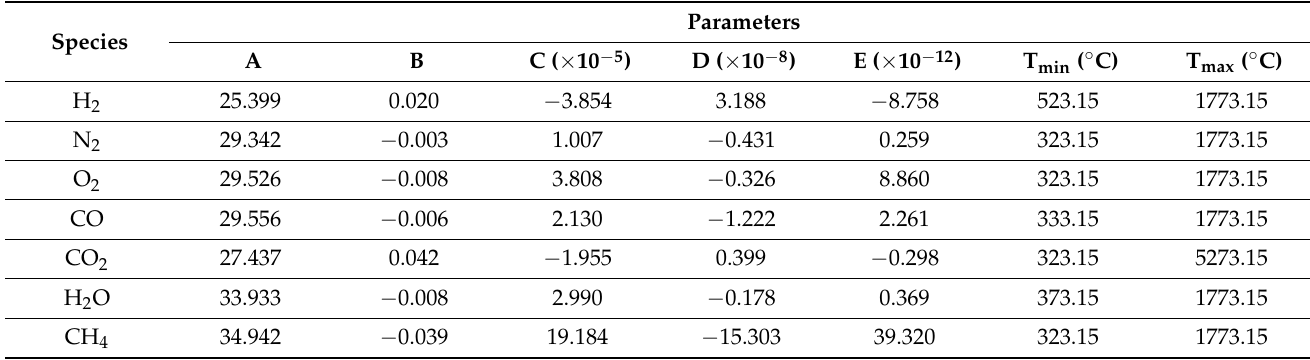
Table A1. Parameters of heat capacity according to chemical species [17].